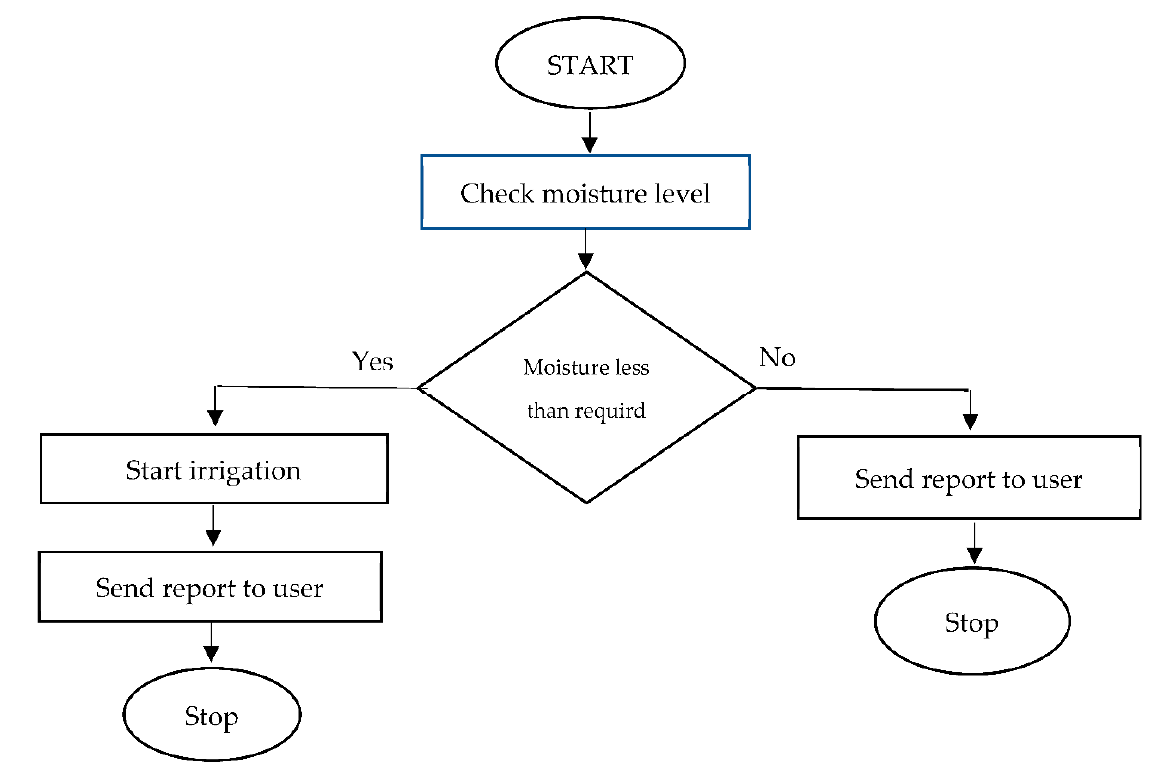
Figure 2. Flowchart of the IoT-based irrigation system.